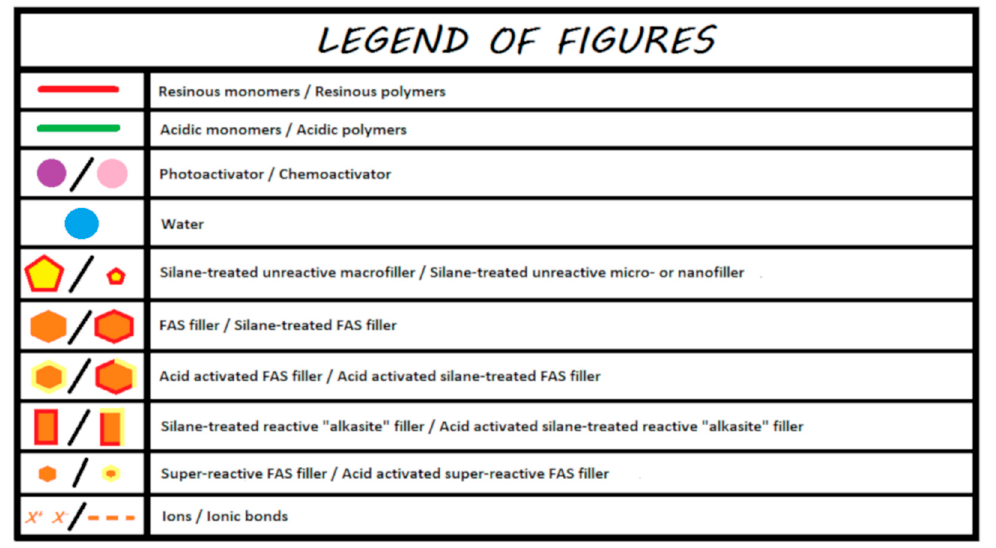
Figure 1. Legends for the illustrations presented in the following figures.